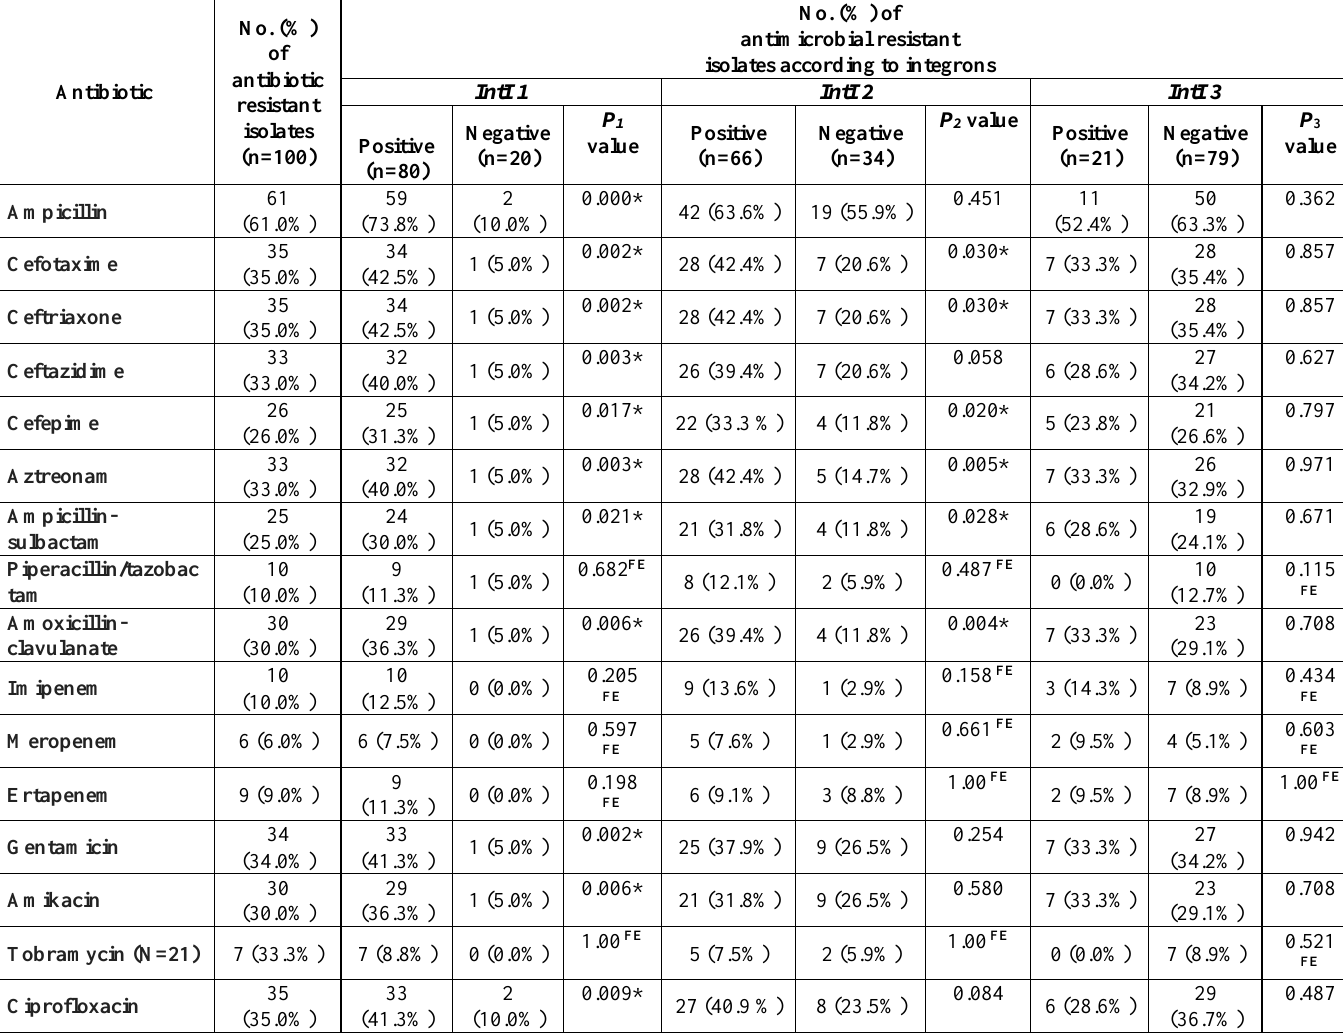
Table 4. Antibiotic resistance pattern of P. mirabilis isolates according to integrons 1, 2, and 3